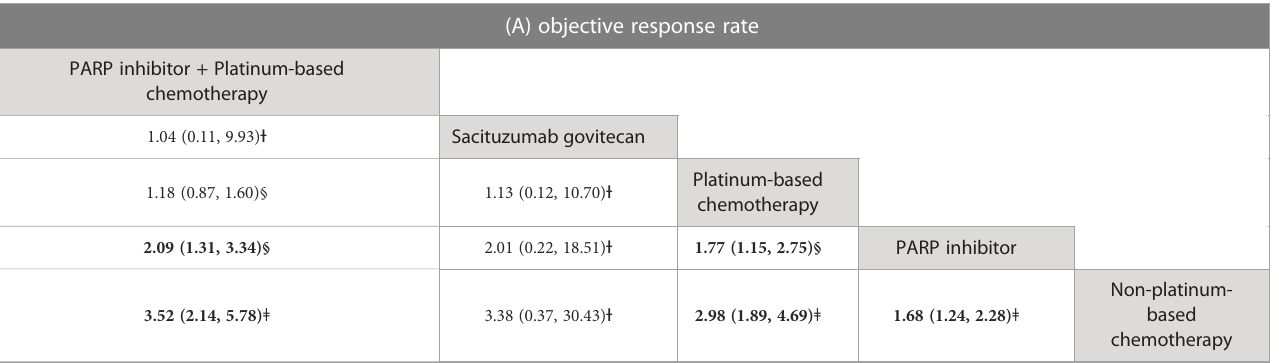
TABLE 2 League tables of network estimates of odds ratios for ef fi cacy outcome